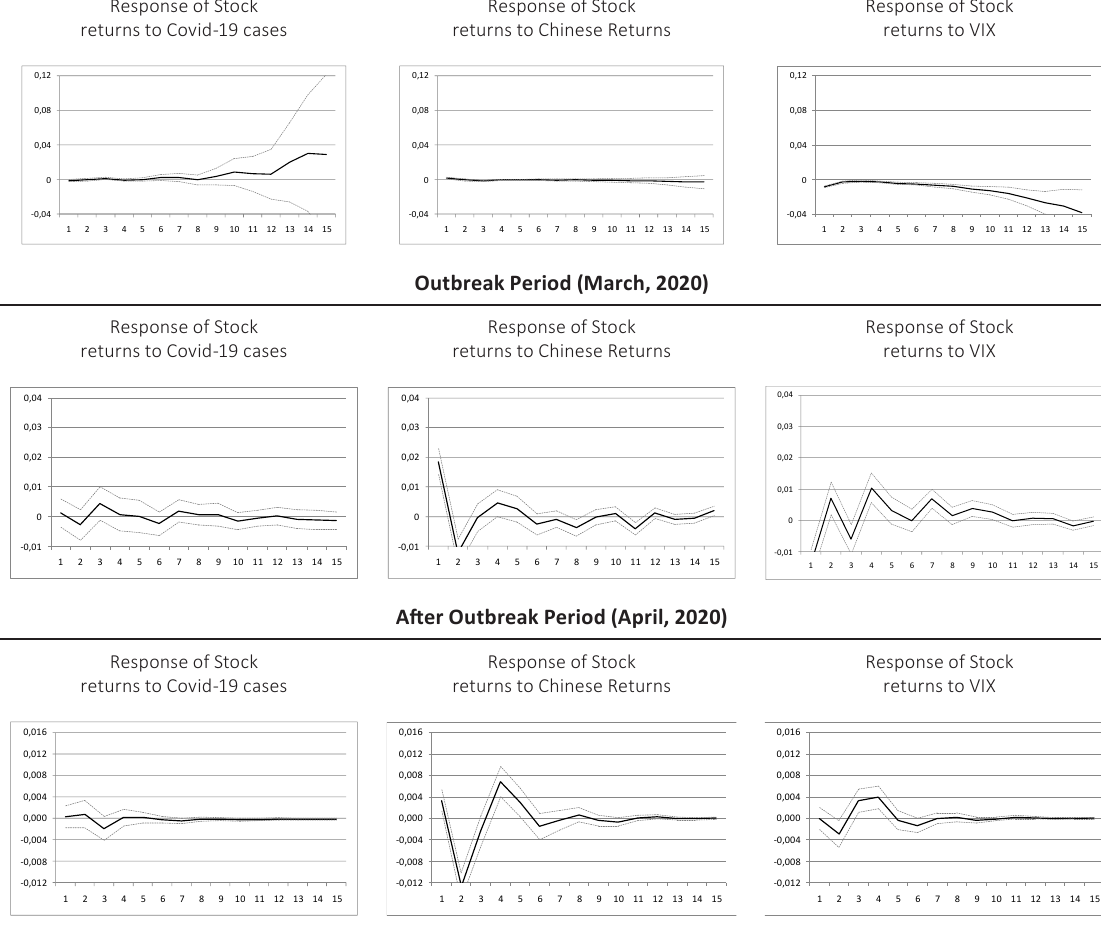
Figure 4. Sub-periods’ generalized impulse response of European stock returns to COVID-19 cases and deaths, Chinese returns and VIX